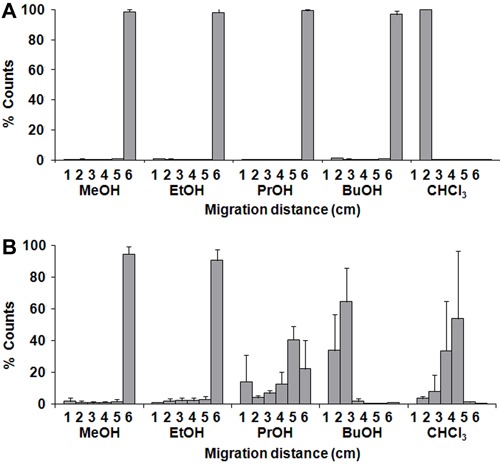
Thin layer chromatography of 99mTcO4
- (A) and
[99mTc(MIBI)6]+(B) reported
as percent of counts in segments of the chromatographic strip (cm), numbers 1 to
6. Alcohols (MeOH: methanol, EtOH: ethanol, PrOH: 1-propanol, BuOH: 1-butanol) or
chloroform (CHCl3) were used as the mobile phase, and ITLC-SG as the
stationary phase. Data are reported as means±SD for n=3.